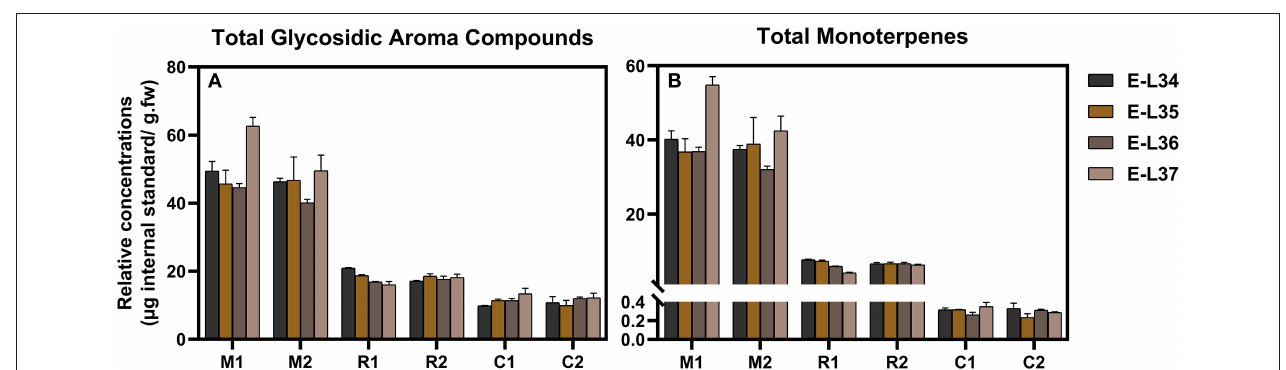
FIGURE 3 | Relative concentrations of total glycosidic compounds (A) and total monoterpenes (B) in three grape varieties (two clones of each) at four ripening stages. M1, M2, R1, R2, C1, and C2 correspond to the clone 1 and clone 2 of Muscat Blanc (M), Riesling (R), and Chardonnay (C), respectively, as described in detail in the Plant materials section. Different colors are used for four ripening stages. The original data used were shown in Supplementary Table 3